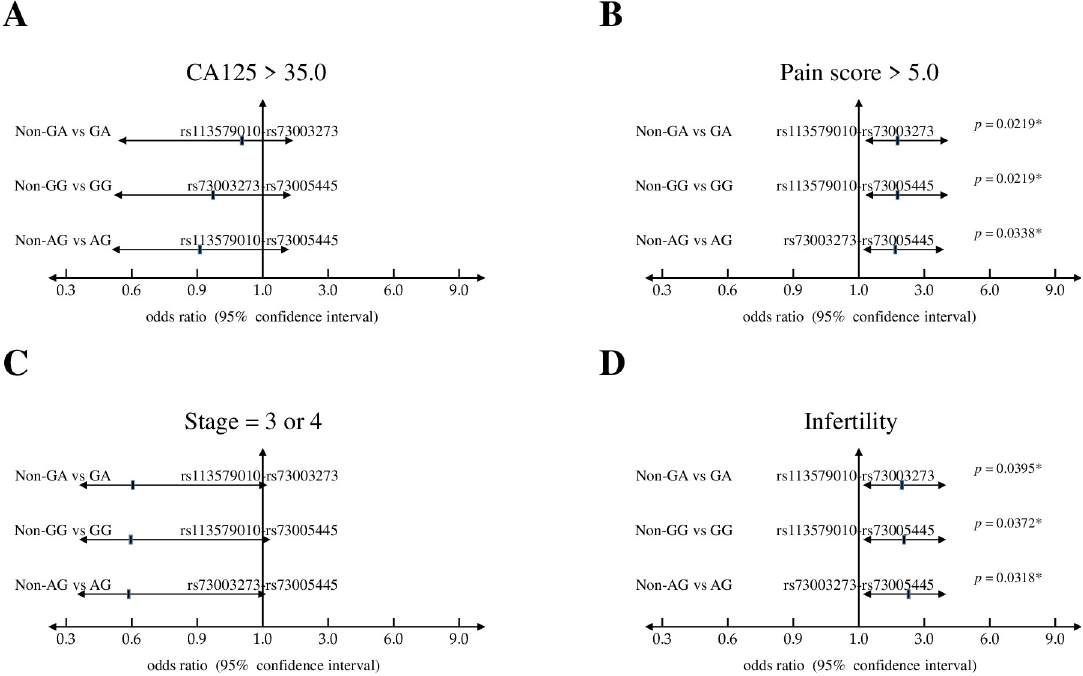
Fig 1. Haplotype analyses of selected functional SNPs in UCA1 and their associations with clinical features of endometriosis patients. Odds ratios and 95% confidence intervals of three risk haplotypes based on clinical features, including ( A ) CA125 levels; ( B ) disease stage; ( C ) pain score; and ( D ) endometriosis-associated